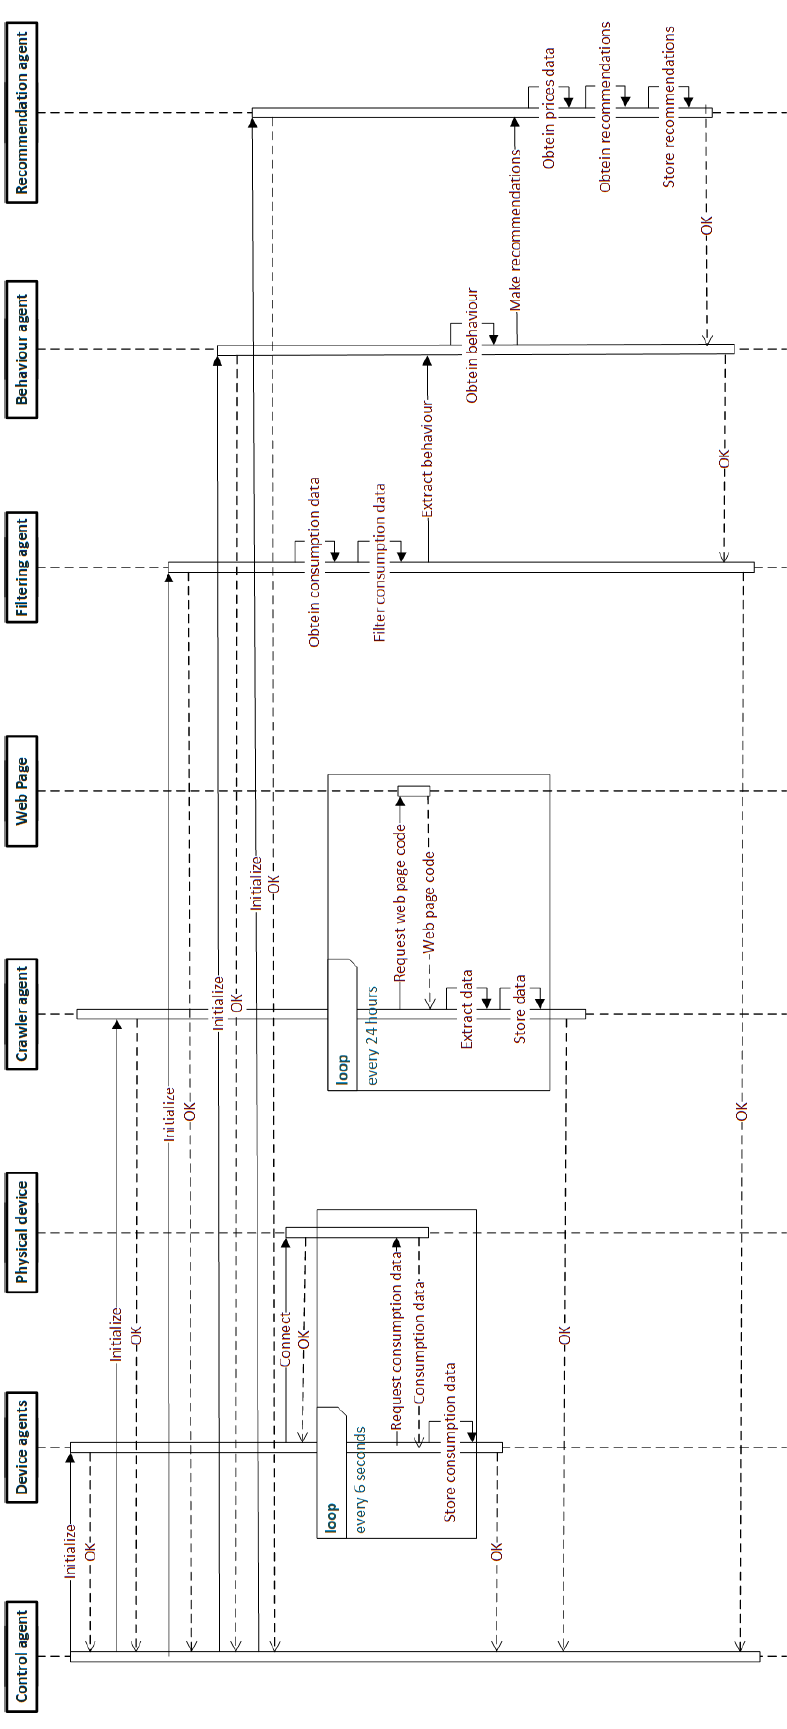
Figure 3. Communication and interactions between